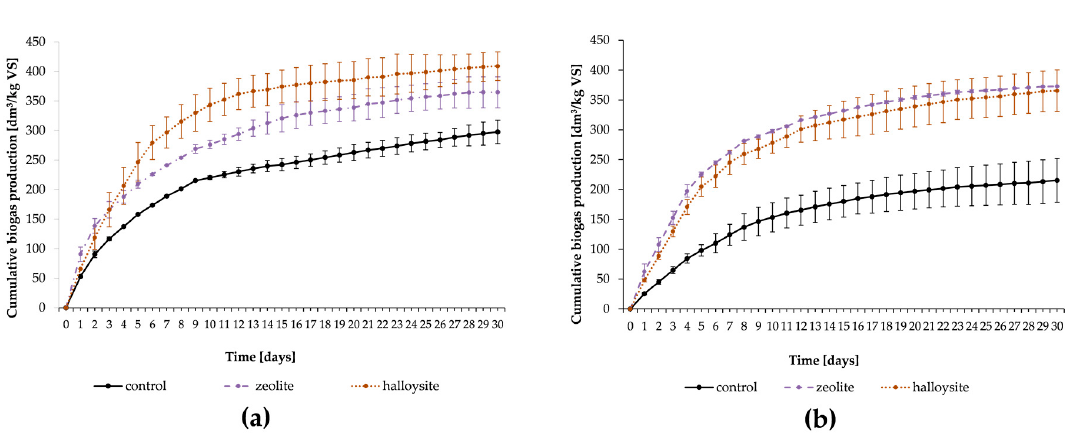
Figure 1. Cumulative biogas production during batch anaerobic digestion of maize silage ( a ) and sludge sewage ( b ) with or without minerals (control). Error bars represent the standard deviation of triplicate measurements.